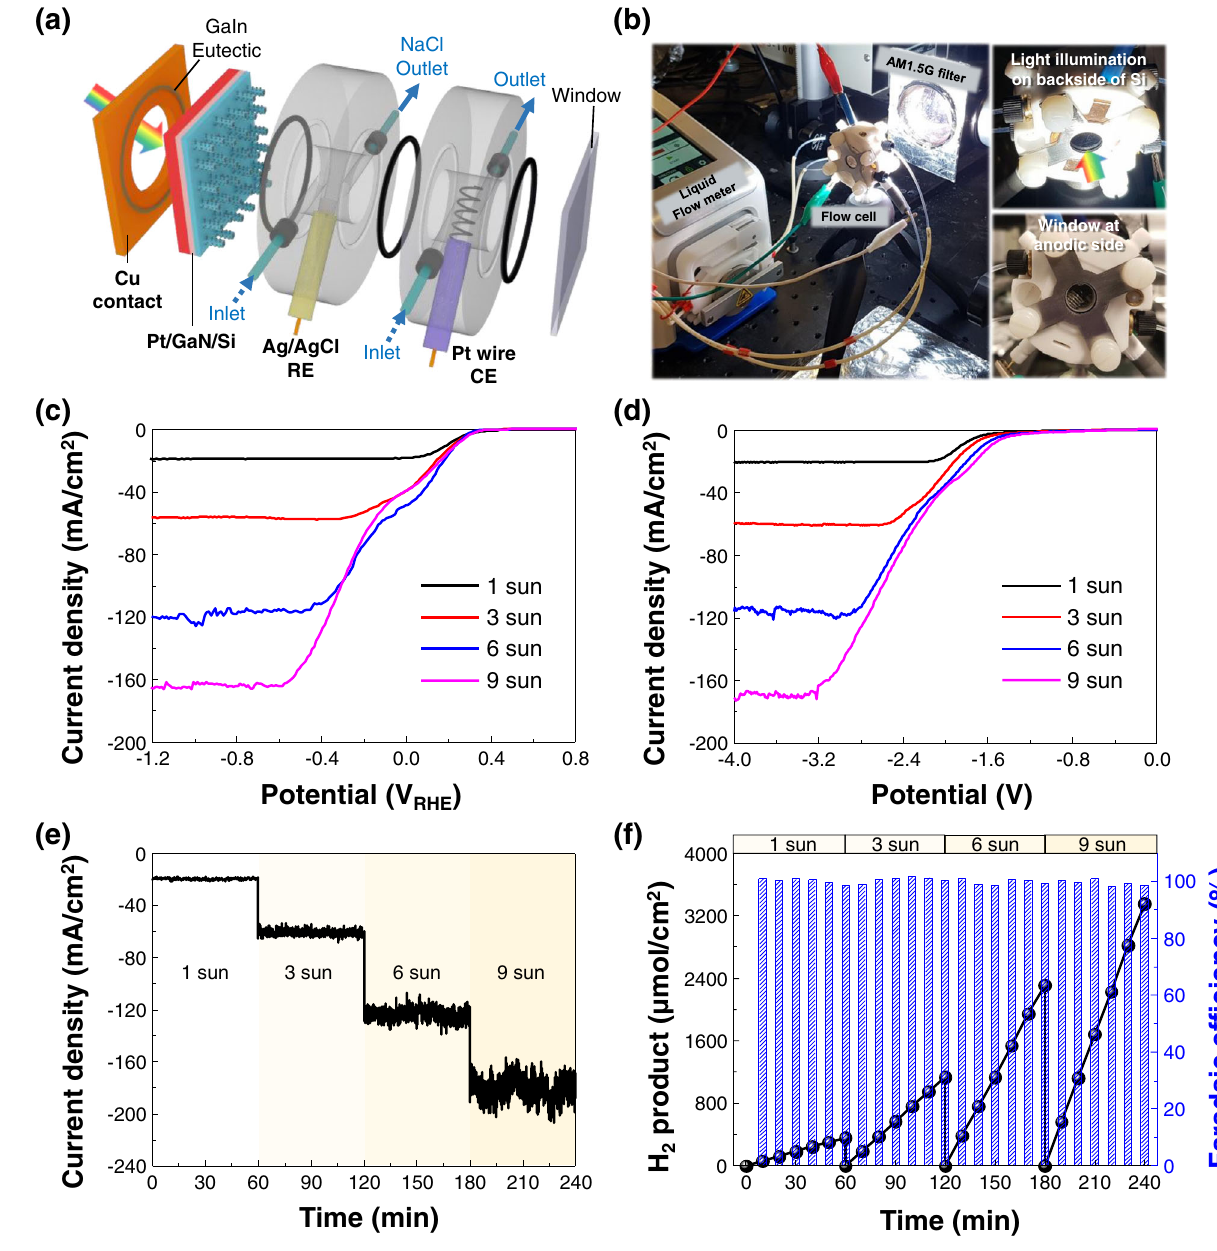
Fig. 4 | Concentratedsolarlight PEC watersplitting. a Schematicillustrationand b photographs of the liquid fl ow cell for PEC water splitting. Light illuminates on the backside of n + -p Si wafer and HER takes place on the front side of Pt/GaN nanowires (NWs). LSV curves of Pt/GaN/Si measured with c 3-electrode and d 2-electrode